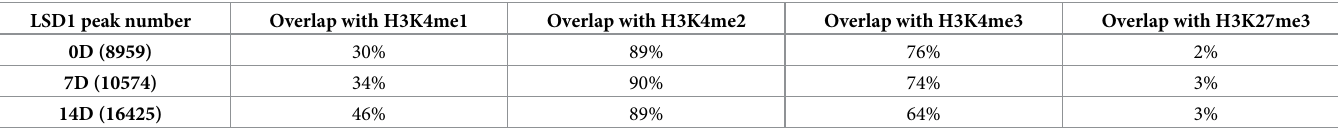
Table 2. Overlapping LSD1 and histone modification